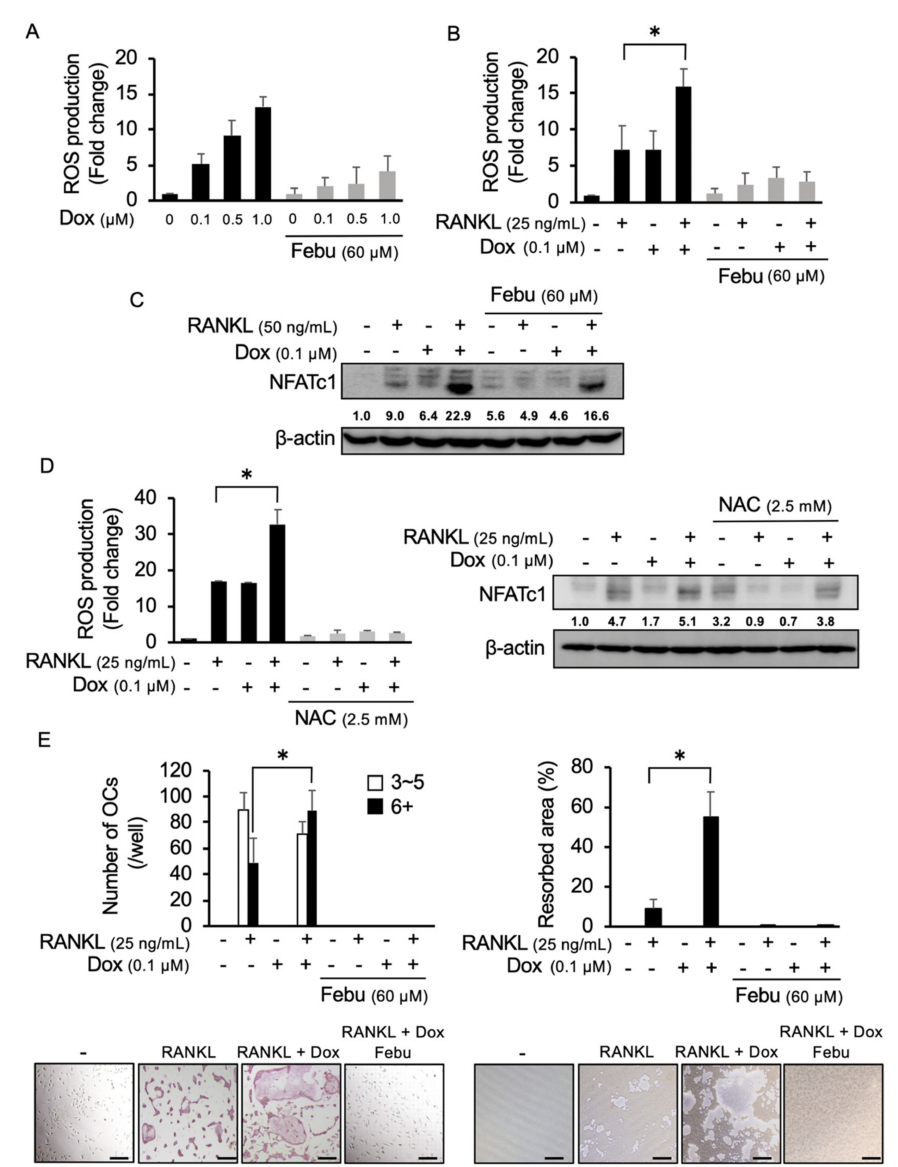
Figure 2. ROS production and osteoclastogenesis by Dox and RANKL in combination. ( A )